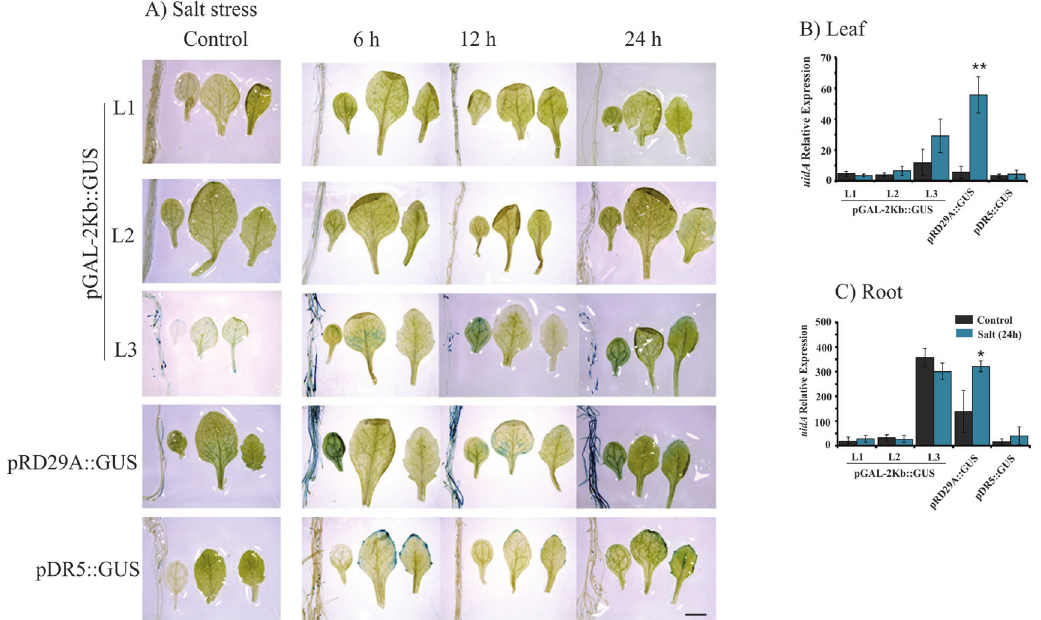
Figure 5 - Histochemical analysis and expression profile analyses of the GUS reporter gene under control of the pGAL -2kb promoter. The order of the samplephotosisasfollows:root,cotyledonalleaf,youngleafandtotallyexpandedleaf.A)Theleavesandrootsofplantsgrownundernormalconditions and salt treatment (6, 12 and 24 h) were compared to the pRD29::GUS and pDR5::GUS plants under normal conditions and treated conditions (6, 12 and 24h).Thedatashownarerepresentativeofthreeindependentlines(n=3).BandC)Theexpressionlevelsof uidA mRNAinleaf androotssamplesunder control (non-treated) and salt treatment. Values are means (cid:5) SD (n = 3). The relative expression values, represented on the y-axis, were obtained by qPCR experiments and calculated using the 2 - (cid:7)(cid:7) Ct method. The At4g34270 and At4g38070 genes were used as endogenous controls to normalize data. Asterisks indicate significant differences of samples under salt treatment and no treatment (Student’s t -test * p < 0.05 and ** p < 0.01). Total RNA was extracted from the leaves and roots of three independent T3 lines of 2-week-old transgenic plants after 24 h of salt treatment. Scale bars = 2